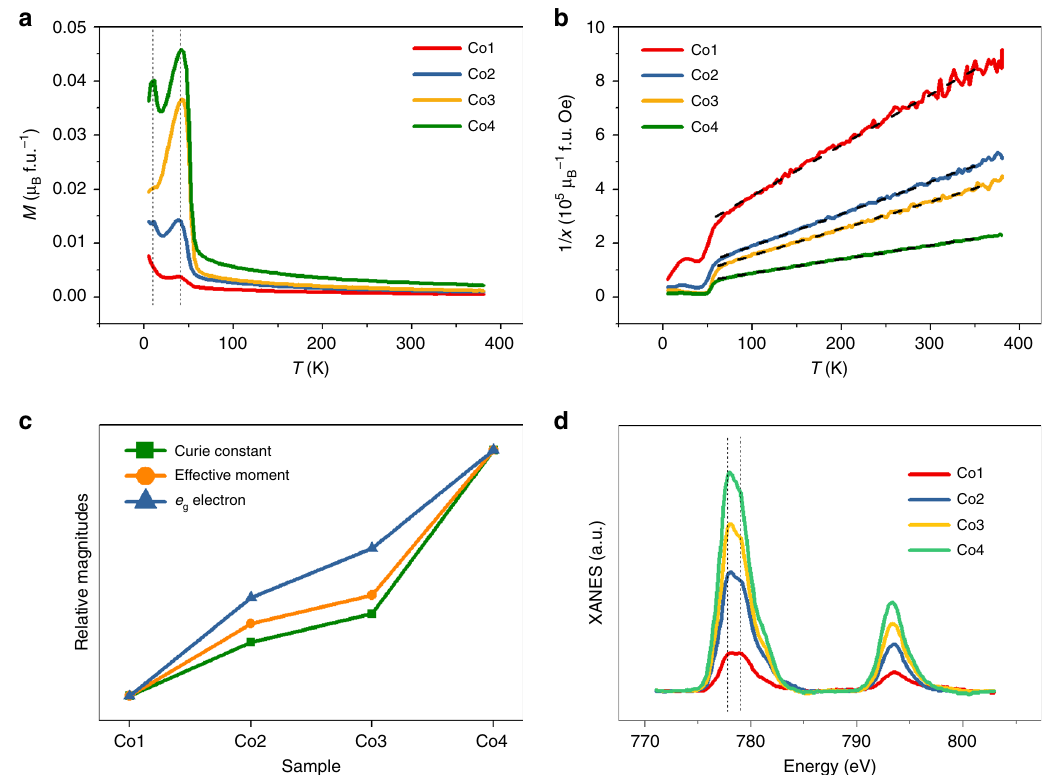
Fig. 4 Electronic structure analysis. a Temperature dependence of the magnetization curves ( M − T ); b inverse susceptibility 1/ χ against temperature; c tendency of C , µ eff , and e g electron number among the four samples; d normalized Co L- edge XAS